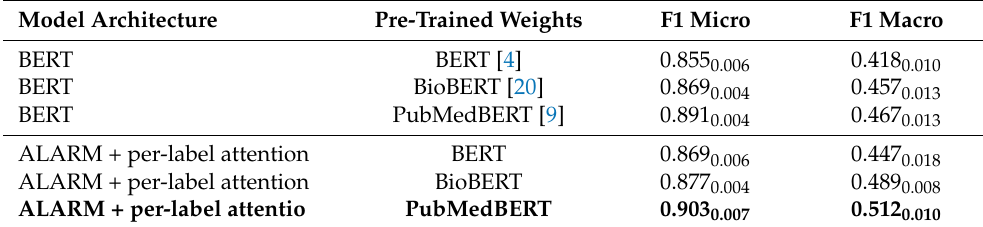
Table 4. Micro- and macro-averaged F1 results as mean standard deviation of 10 runs with different random seeds. Bold indicates the best model for each metric.